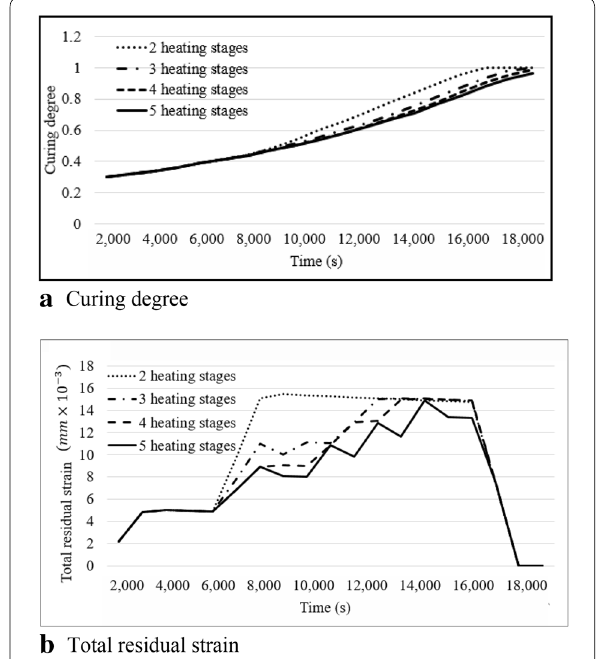
Figure 23 Results of curing analyses according to the number of heating stages